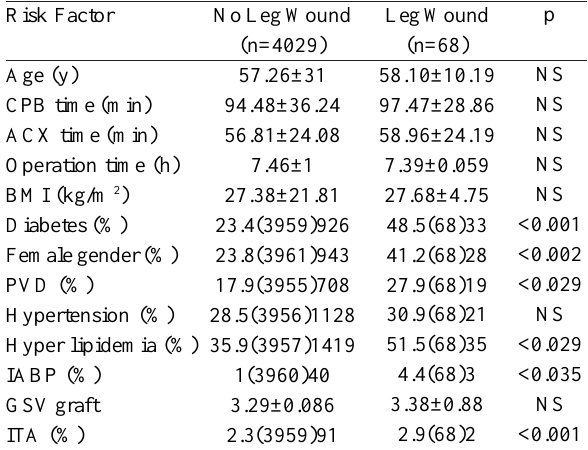
Table 2. Postoperative complications and surgical procedures